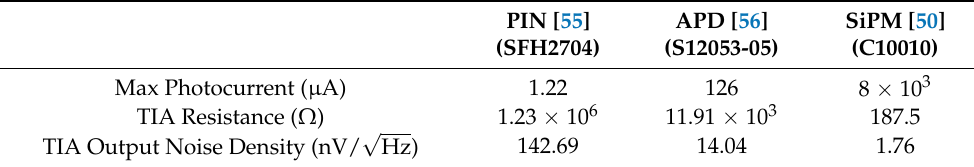
Table 4. Current to voltage conversion noise contribution for each photodetector.